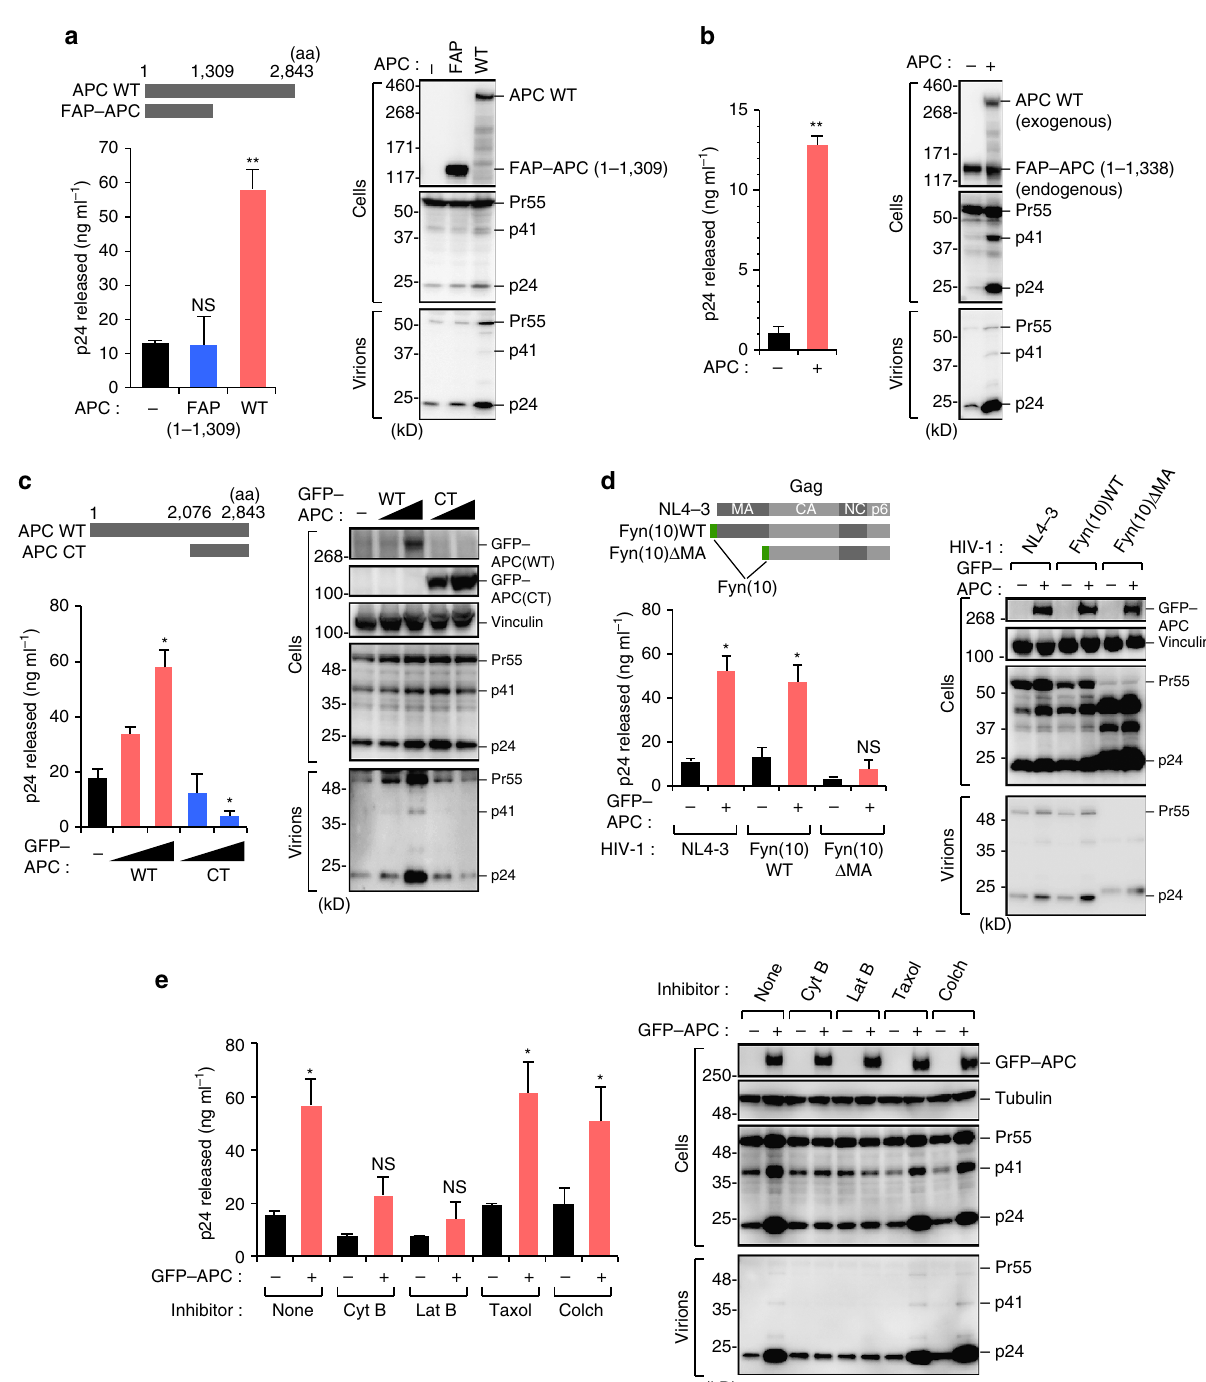
Figure 3 | APC facilitates HIV-1 particle production. ( a , b ) HEK293 ( a ) and SW480 ( b ) cells were co-transfected with pNL4-3 and plasmids encoding APC (WT or its FAP-related mutant). At 48h after transfection, cells and supernatants were collected and analysed by immunoblotting using the indicated antibodies. The bar charts indicate the viral p24 antigen levels in the culture supernatants. ( c ) HEK293 cells were co-transfected with pNL4-3 and plasmids encoding APC (WT or its C-terminal domain, CT). At 48h after transfection, culture supernatants and cell lysates were analysed by p24 enzyme-linked immunosorbent assay (ELISA) and immunoblotting, respectively. ( d ) HEK293 cells were transfected with vectors encoding GFP–APC and the indicated molecular clones encoding WTor MA-deleted Gag. At 48h following transfection, culture supernatants and cell lysates were analysed by p24 ELISA and immunoblotting. ( e ) HEK293 cells were co-transfected with pNL4-3 and the indicated plasmids encoding APC. The indicated inhibitors were added to cells at 20h before collecting. At 48h following transfection, culture supernatants and cell lysates were analysed by p24 ELISA and immunoblotting. The final concentrations of inhibitors were as follows: Cyt B, Cytochalasin B (20 m M); Lat B, Latrunculin B (5 m M); Taxol (100nM); Colch, Colchicine (50 m gml (cid:2) 1 ). All graphs are presented as a mean ± s.d. ( n ¼ 3). NS, not significant; * P o 0.05, ** P o 0.01, two-tailed unpaired t -test. Full images for all immunoblots are provided in Supplementary Fig.